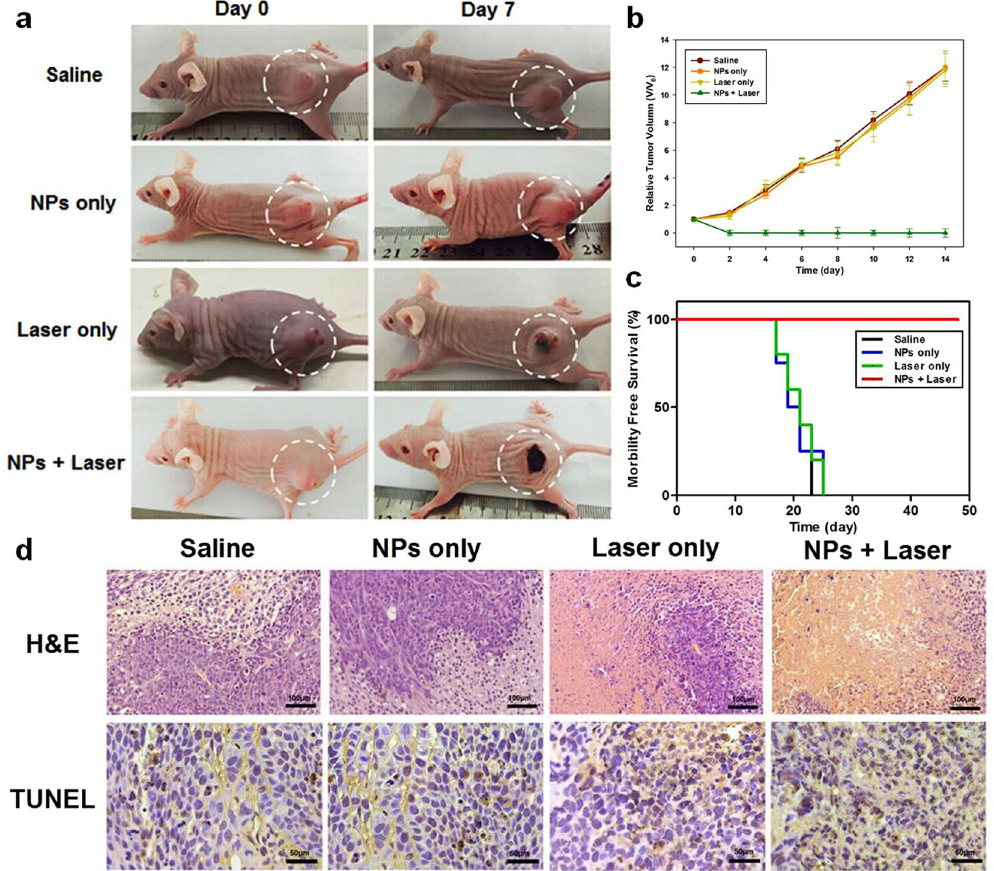
Figure 6. In vivo cancer therapy. ( a ) Representative photographs of mice from different groups at day 0 before treatment and at day 7 after treatment. ( b ) Tumor growth curves of mice after different treatments indicated. ( c ) Morbidity-free survival data after different treatments. ( d ) H&E and TUNEL staining of sections of tumors harvested 1 day after the different treatments. (H&E staining: 100 × ; scale bar, 100 μ m; TUNEL staining: 200 × ; scale bar, 50 μ